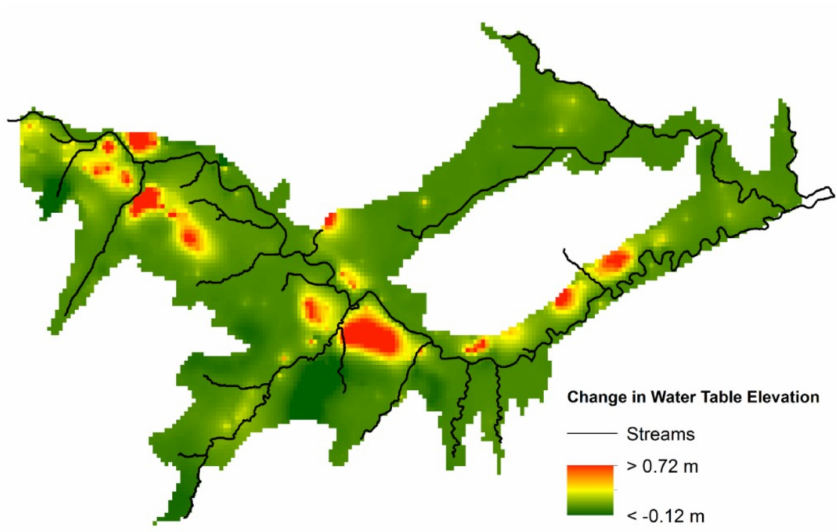
Figure 14. Average increase in groundwater level between the reduced irrigation scenario and the baseline scenario over the 1999–2016 time period.